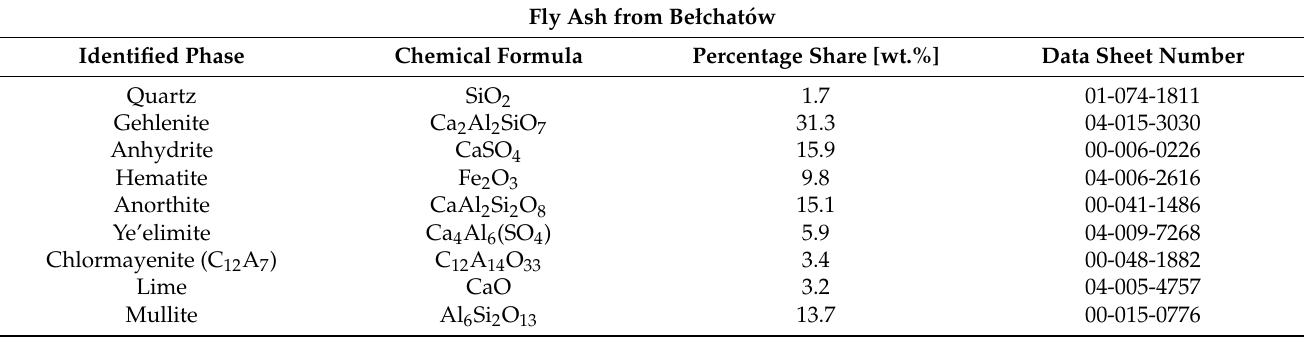
Table 5. Phase analysis of the Belchat ó w lignite fly ash. Fly Ash from Bełchat ó w